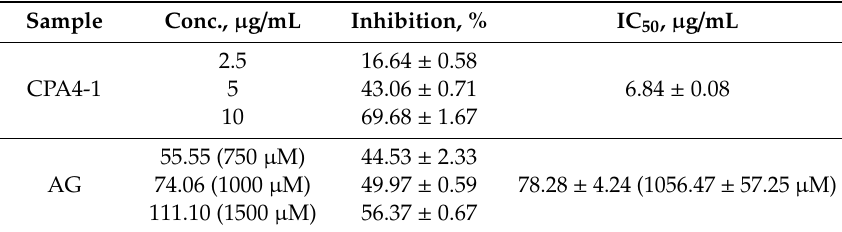
Table 3. Inhibitory effect of CPA4-1 on the formation of advanced glycation end product (AGE). Sample